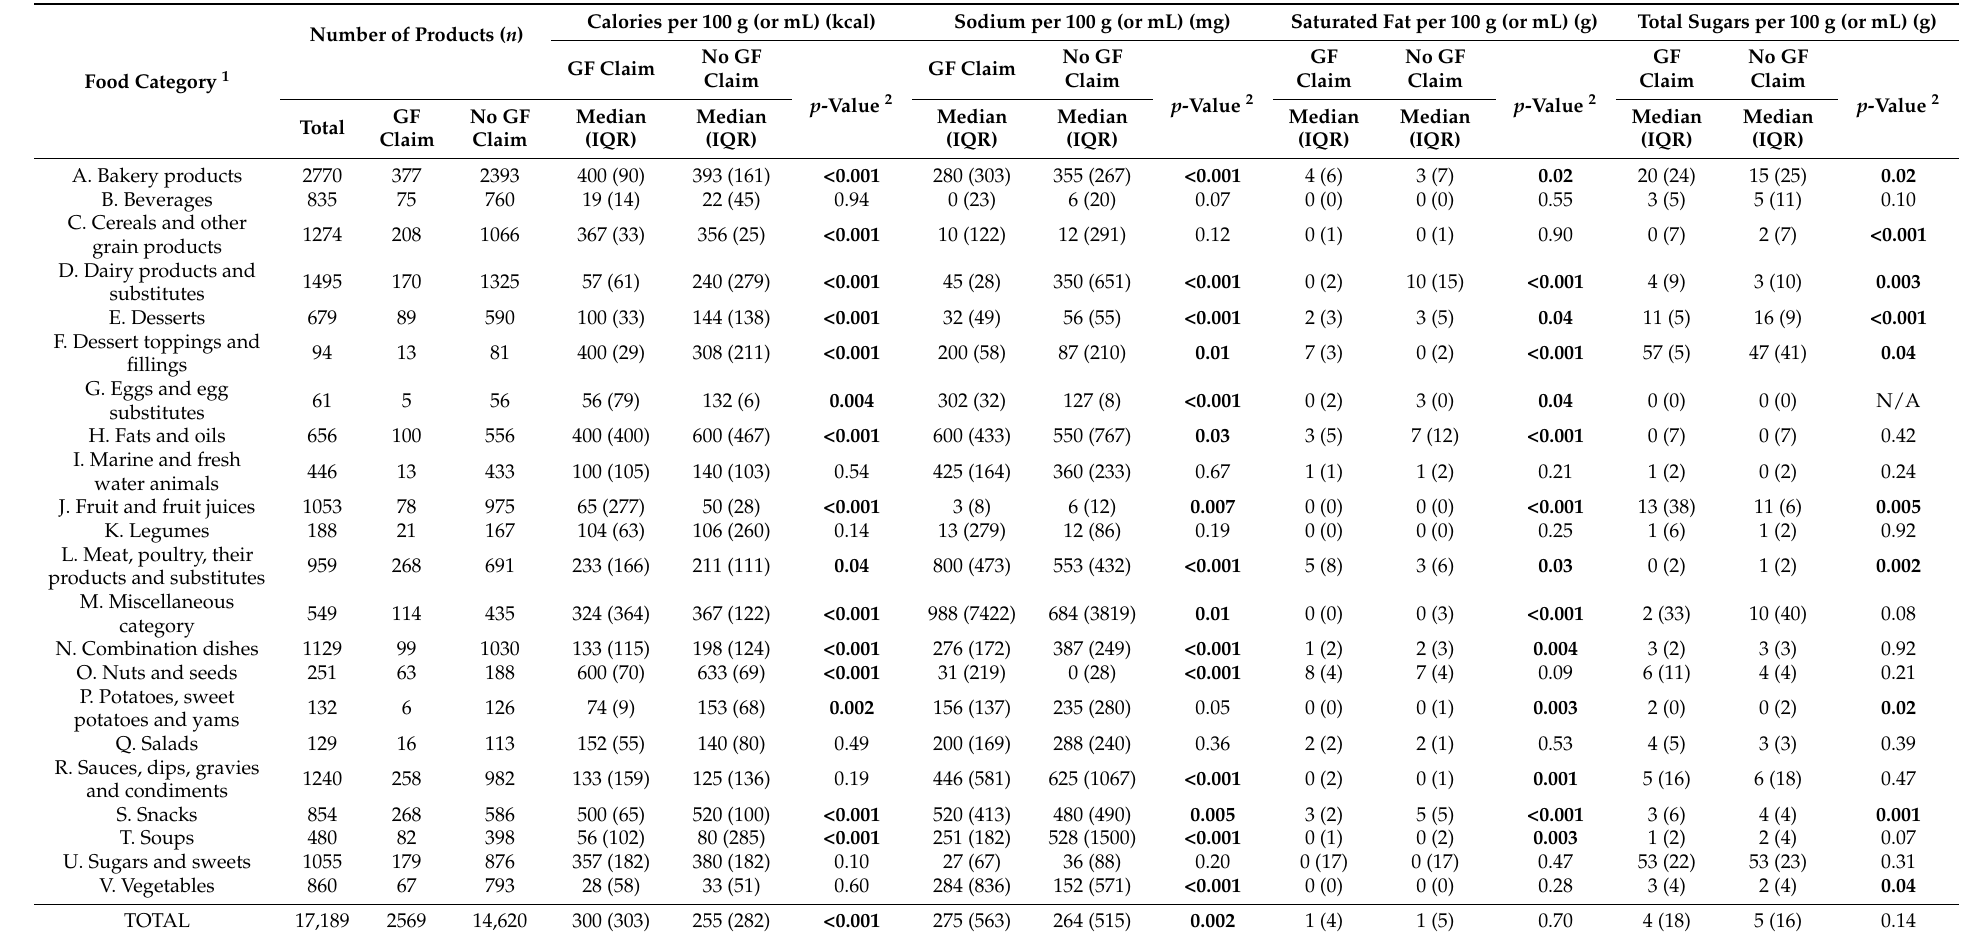
Table 3. The nutritional composition per 100 g (or mL) of products with and without gluten-free (GF) claims in